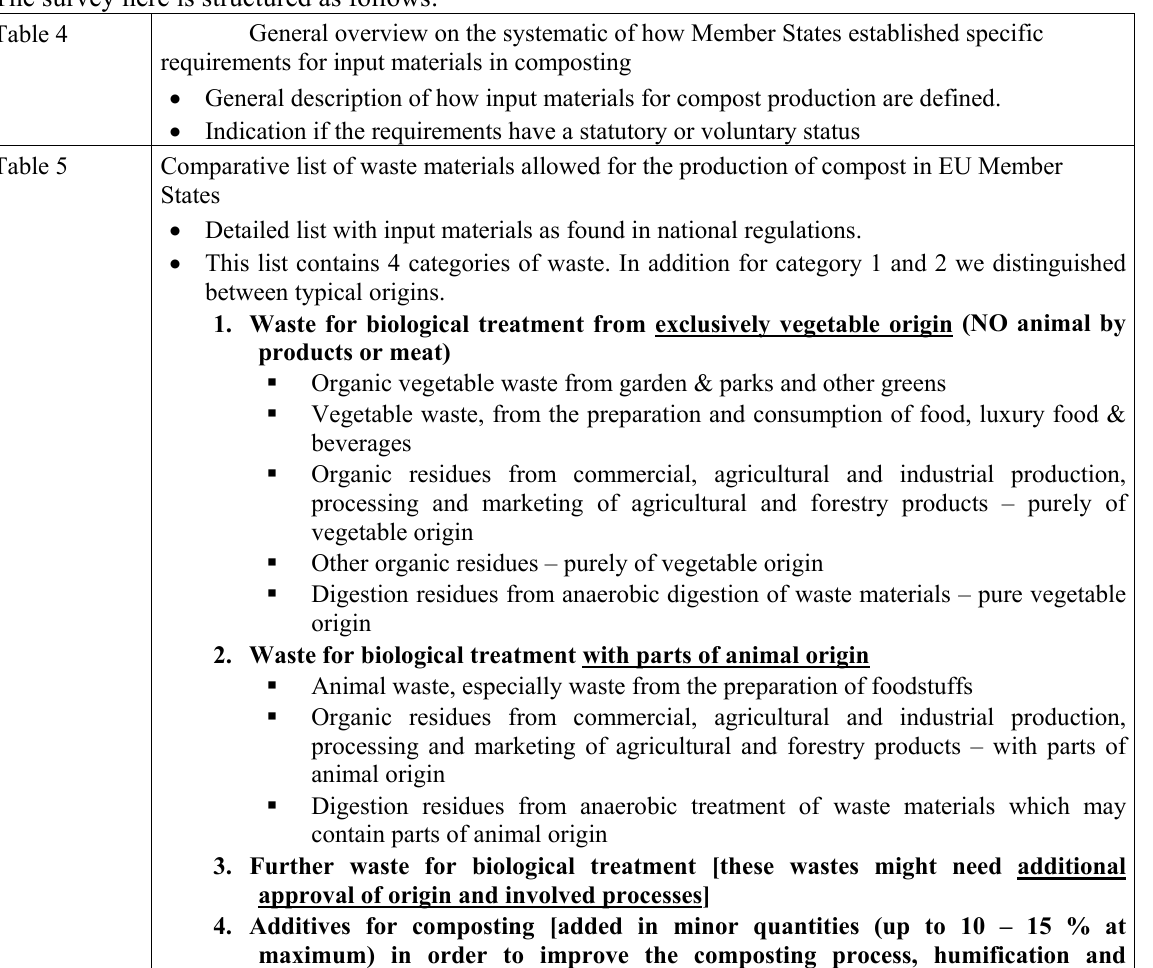
Comparative list of waste materials allowed for the production of compost in EU Member